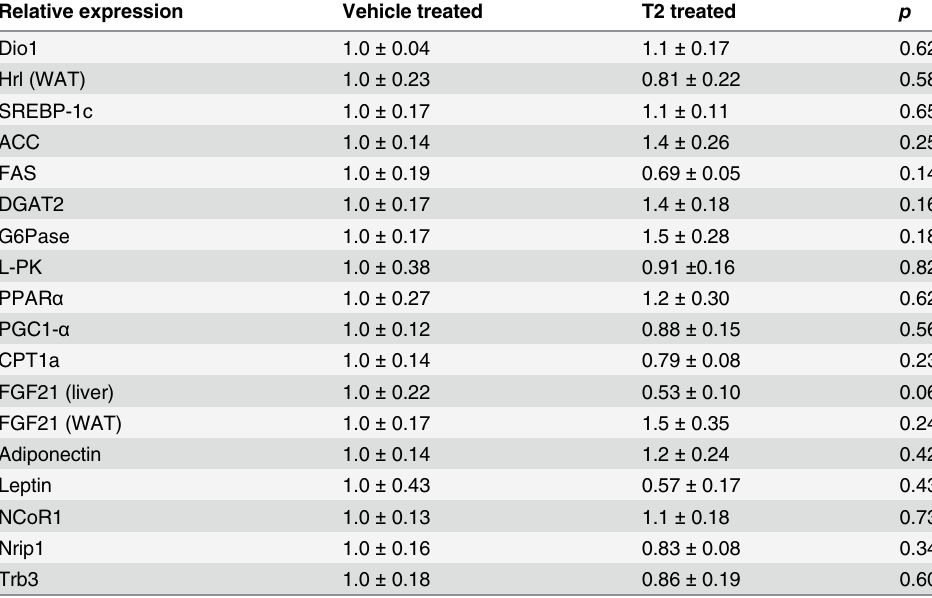
Dio1: Deiodinase 1; Hrl: Hairless; WAT: White adipose tissue; SREBP-1c: Sterol regulatory element binding protein 1c; ACC: Acetyl CoA Carboxylase; FAS: Fatty acid synthase; DGAT2: Diacylglycerol O- acyltransferase 2; G6Pase: Glucose 6 Phosphatase; L-PK: L-Pyruvate kinase; PPAR α : Peroxisome proliferator-activated receptor alpha; PGC1- α : Peroxisome proliferator-activated receptor gamma coactivator 1-alpha; CPT1a: Carnitine Palmitoyltransferase-1A; FGF21: Fibroblast growth factor 21; NCoR1: Nuclear receptor corepressor 1; Nrip1: Nuclear receptor interacting protein 1; Trb3: Tribbles pseudokinase 3. n = 4 – 10 per